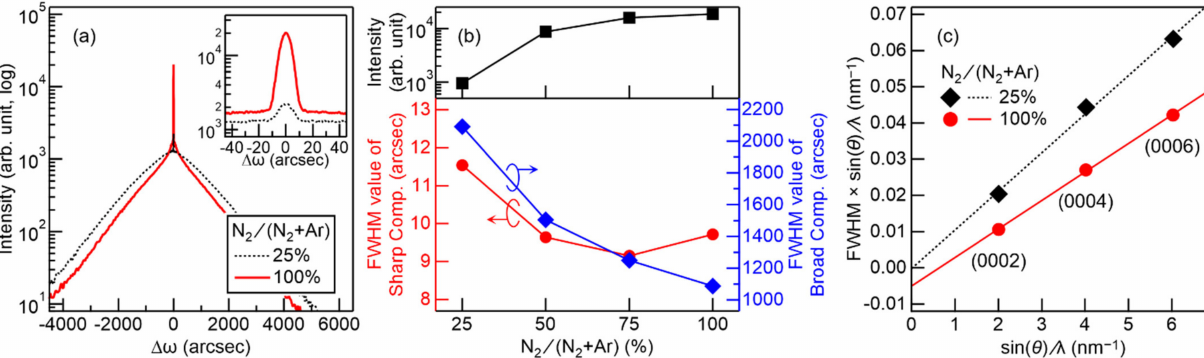
Figure 3. ( a ) High-resolution X-ray rocking curve (XRC) profiles of AlN(0002) diffraction of the as-sputtered AlN films using N 2 /(N 2 + Ar) ratios of 25% and 100% that were measured at a fixed value of 2 θ to include the peak top of the RSM images shown in Figure 2. The inset shows the enlarged profiles of the sharp component. ( b ) Effect of N 2 /(N 2 + Ar) ratio on the peak intensity of the sharp component and XRC full width at half maximum (XRC-FWHM) values of the sharp component and broad component of the AlN(0002) diffraction. ( c ) Williamson–Hall plot of as-sputtered AlN films: for (0002) diffraction, the FWHM values of the broad component in the high-resolution XRC profiles shown in ( a ) were used; for the (0004) and (0006) diffractions, the FWHM values were evaluated from the XRD-RSM images shown in Figure 2. The lines are the linear